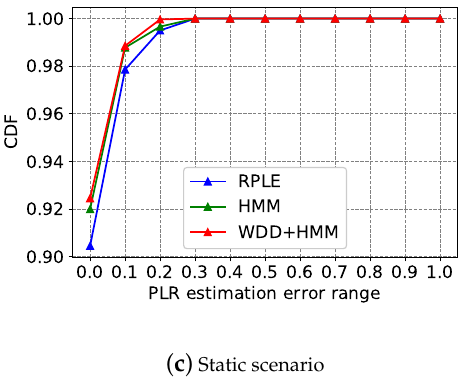
Figure 7. Comparison of estimation error range of PLR for different methods.